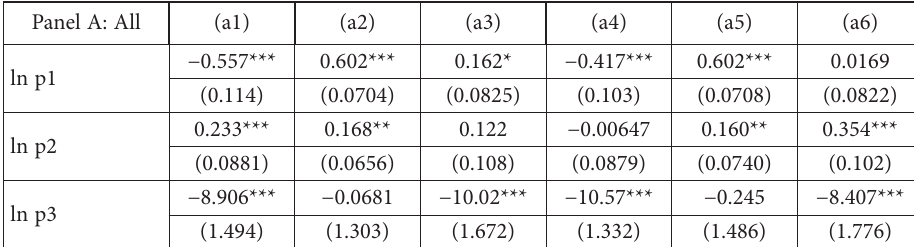
Table 5. Panzar-Rosse results for competitive conditions in Takaful insurance in Malaysia Panel A: